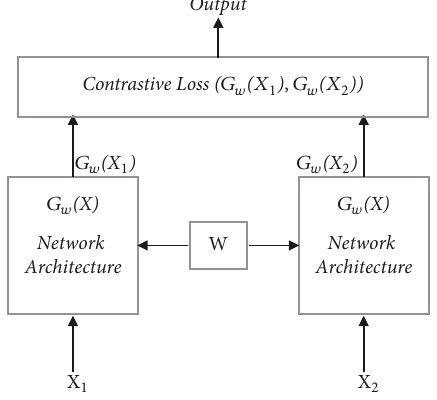
Figure 6: Siamese Network Architecture. Two inputs 𝑋1 and 𝑋2 are fed into two identical networks. 𝐺 transformation of the input 𝑋 . 𝑊 is the shared weights between the two heads of the Siamese